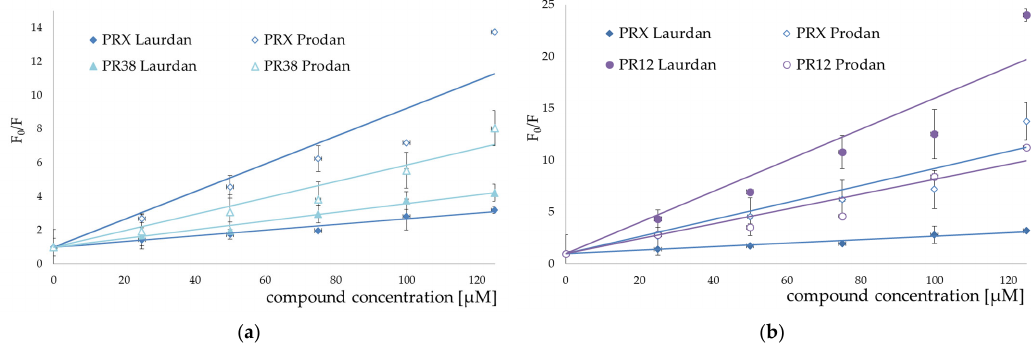
Figure 8. Stern–Volmer plots for PR38 ( a ) and PR12 ( b ) induced quenching of Laurdan (full symbols) and Prodan (open symbols) fluorescence; mean ± SD, n = 3. Stern–Volmer plots for piroxicam ‐ induced quenching of Laurdan and Prodan fluo ‐ rescence are also provided for comparison. Bars represent standard deviations of three independent experiments. Where no error bars are shown, it means that they were smaller than the symbols representing the results.